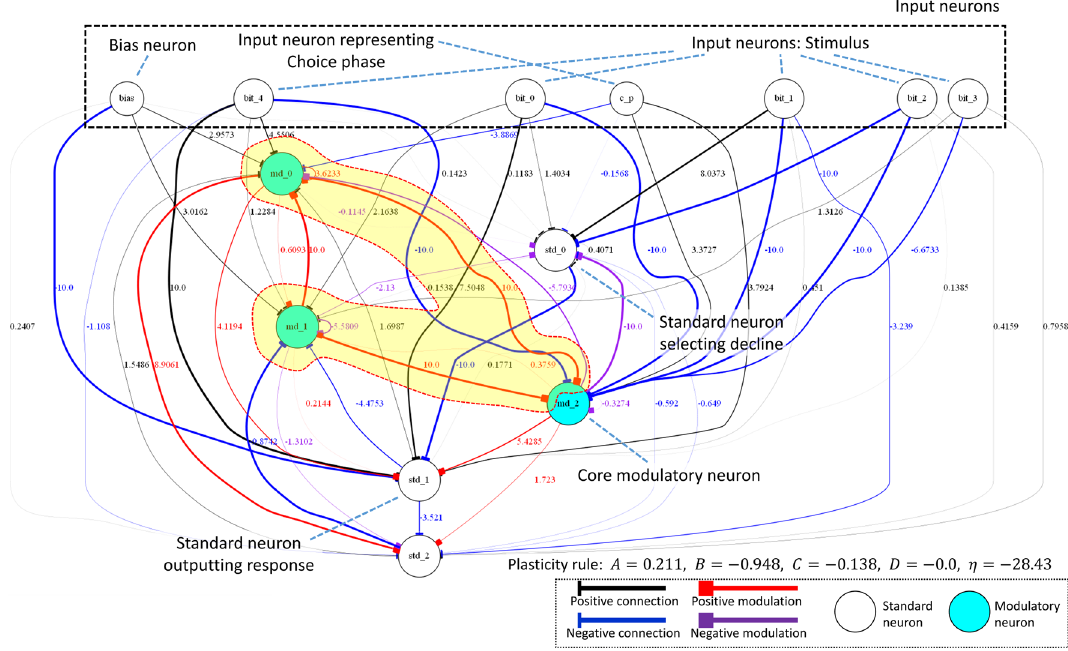
Figure 9. Structure of the evolved neural network. The width of each line represents the weight of a